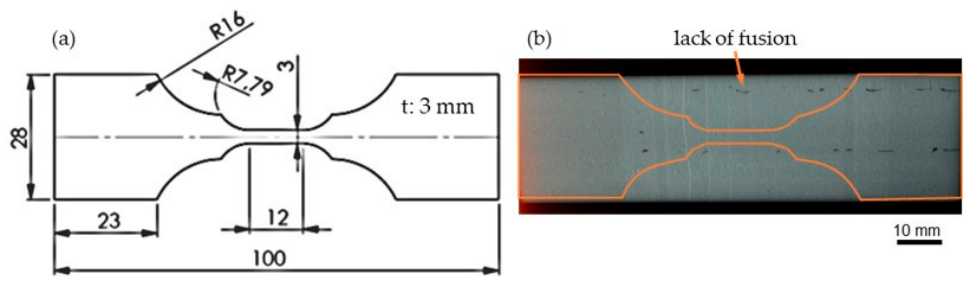
Figure 15. ( a ) Geometry of hot tensile specimens. ( b ) X-ray images of a flat specimen of block with Z-ArHeNC-5/5/0.05 digitized with a reflex camera.